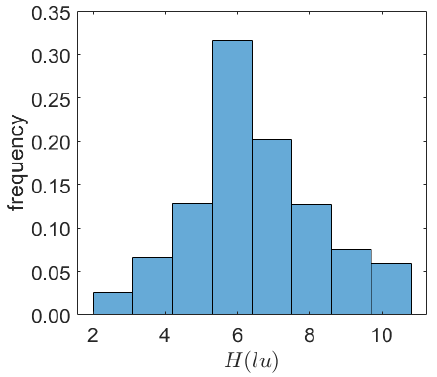
Figure 5. Distribution of local characteristic length 𝐻 in lattice units.